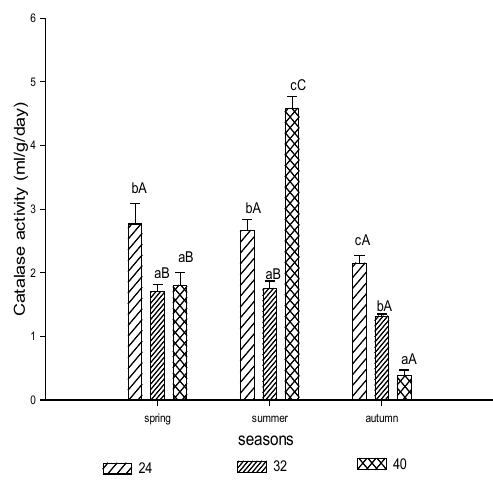
Figure 3. Influence of time since thinning (24, 32 and 40 years) and season on soil catalase activity. Capital letters indicate statistically significant differences among season within each time since thinning; lowercase letters indicate statistically significant differences among times since thinning within the same season. Bars indicate the standard error of the mean.